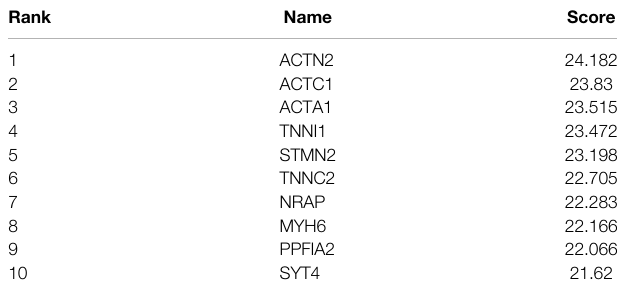
TABLE 4 | Top 10 genes ranked by the MCC method. TABLE 5 | Top 10 genes ranked by the EPC method.